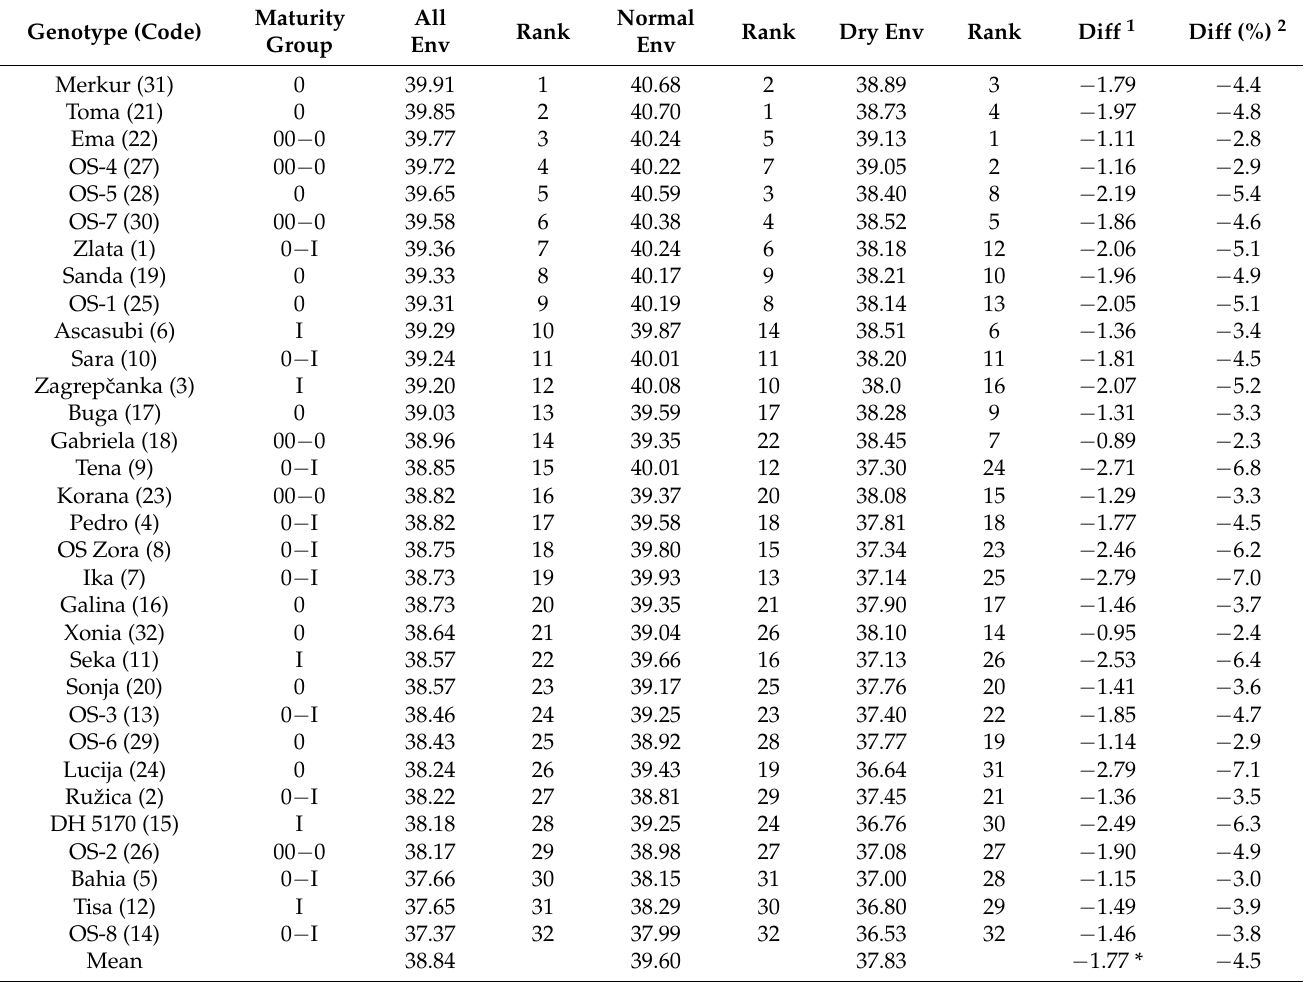
Table 5. Mean protein content (%) of 32 soybean genotypes across all, normal and dry environments with the corresponding ranks within each group of environments. Genotypes are presented in descending order based on their mean values across all